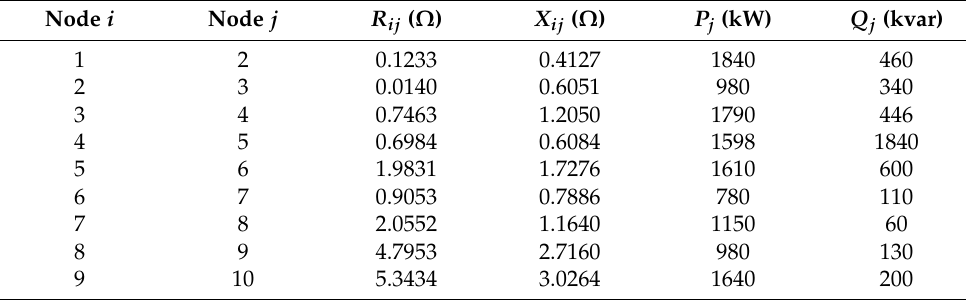
Table 4. Parameters of the 10-node